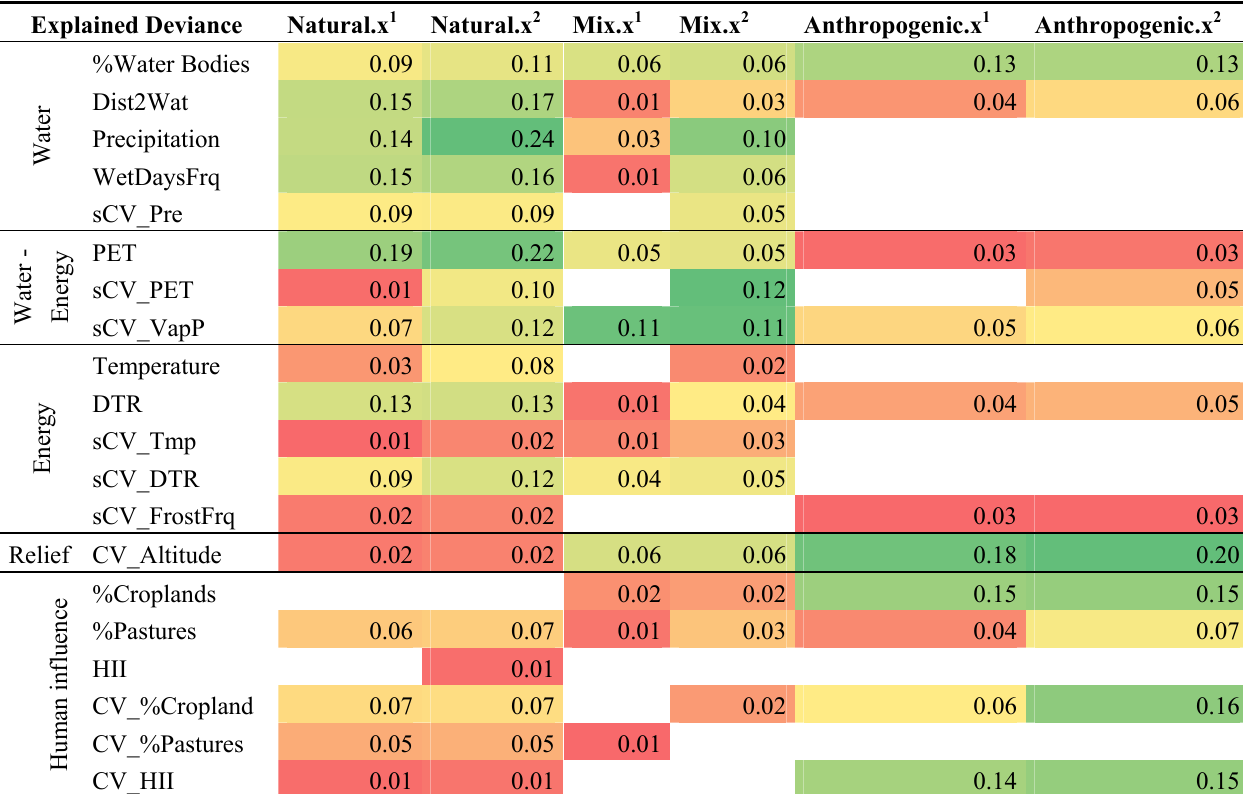
Table 1. Deviance explained by the different Poisson Generalized Linear Models fitted between EFT richness and each explanatory variable (x 1 column) or its quadratic transformation (x 2 column). Models were compared across a gradient of the Human Influence Index (HII): Natural ecosystems (0 < HII < 10), mixed (10 < HII < 20) and anthropogenic systems (20 < HII < 40). Deviances are shown where p-values for the ANOVA Chi 2 tests are lower than 0.01. The color scale is used to visualize, in green, those models that cumulated the greatest explained deviances and, in red, the lowest within the same category of human